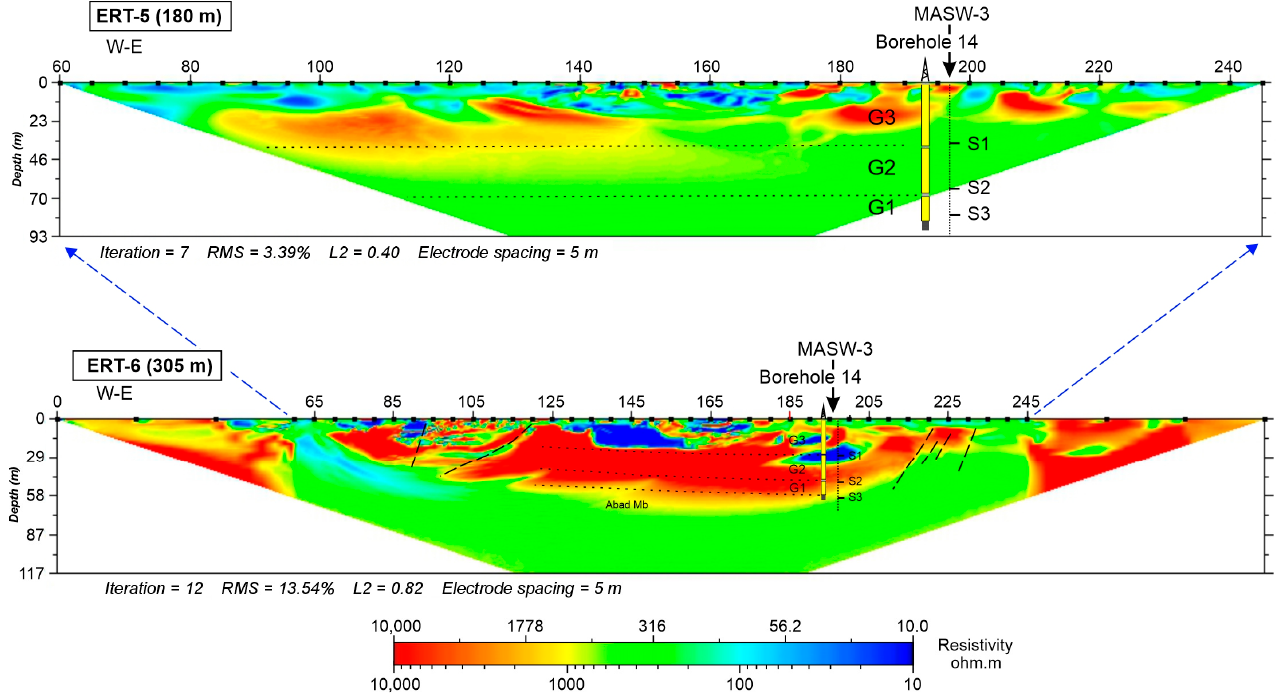
Figure 13. Inverted electrical resistivity tomography data of the northeast area, where borehole 14 occurs. The borehole and seismic survey point (MASW-3) are indicated. ERT-6 is along the same lines as ERT-5, although ERT-6 is longer and reaches greater depths.